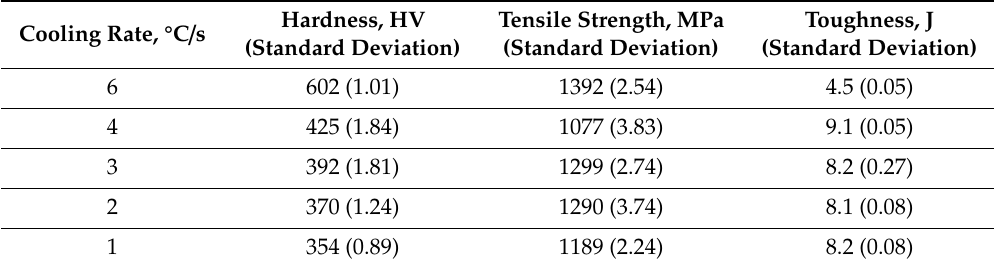
Table 2. Mechanical properties at di ff erent cooling